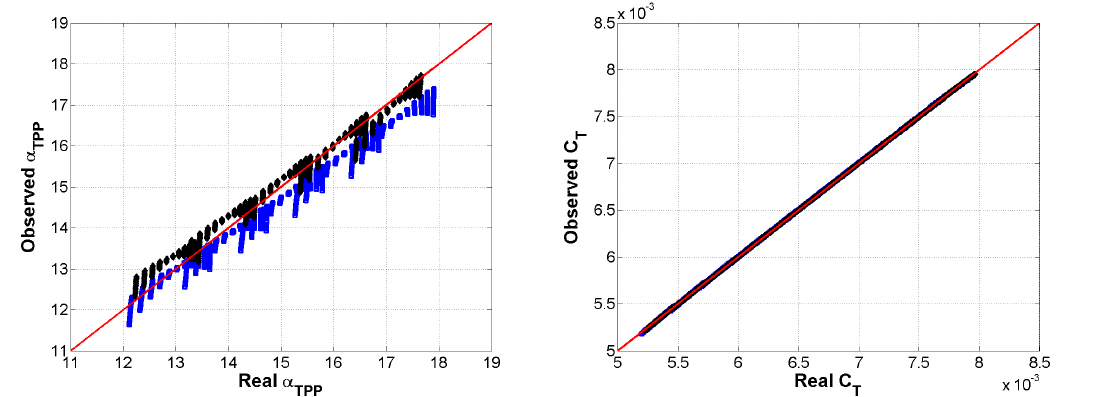
Figure 27: Observation quality check for TPP-AOA (left) and thrust coeflcient (right) at 35 and 45 kn airspeed, altitudes varying between 3,000 and 500 ft, weight varying between 68% and 100% of reference value. Red line: ideal correlation. Black diamonds and blue squares: results from sampled time histories at 35 and 45 kn,